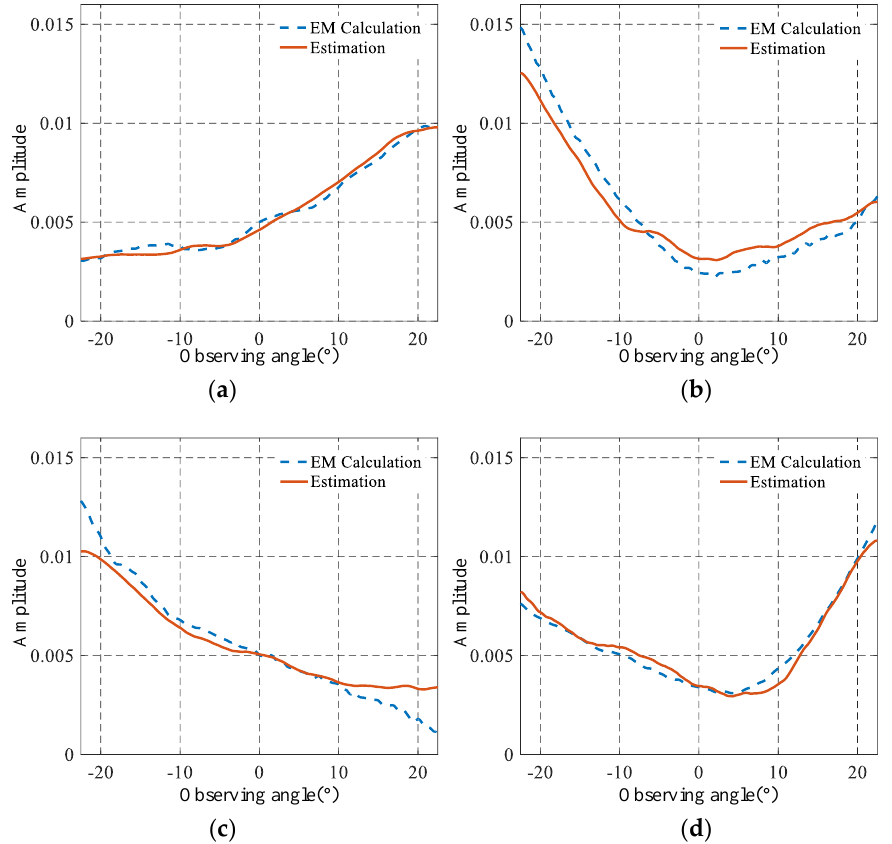
Figure 13. The comparisons between the estimated and calculated amplitudes. ( a ) Scatterer 1; ( b ) Scatterer 2; ( c ) Scatterer 3; ( d ) Scatterer 4.